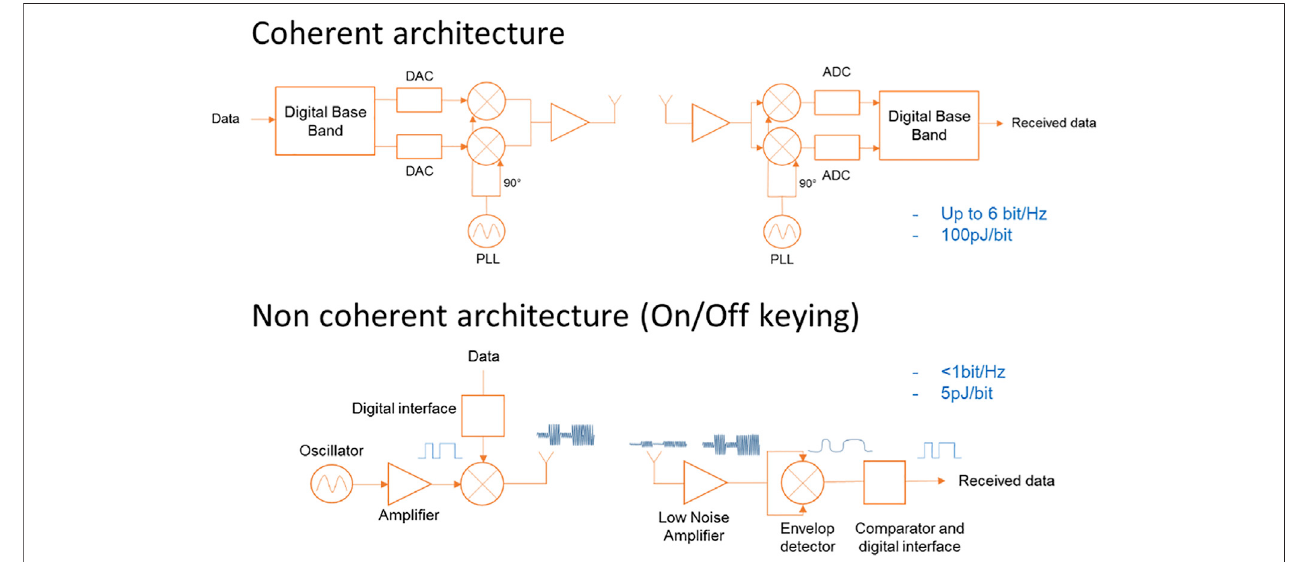
FIGURE 1 | Coherent (A) and non-coherent (B) RF architecture